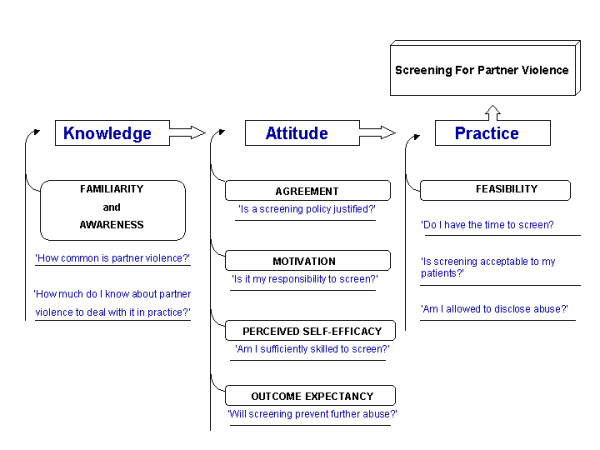
Conceptual framework of knowledge, attitude, and practice as determinants of screening for intimate partner violence.